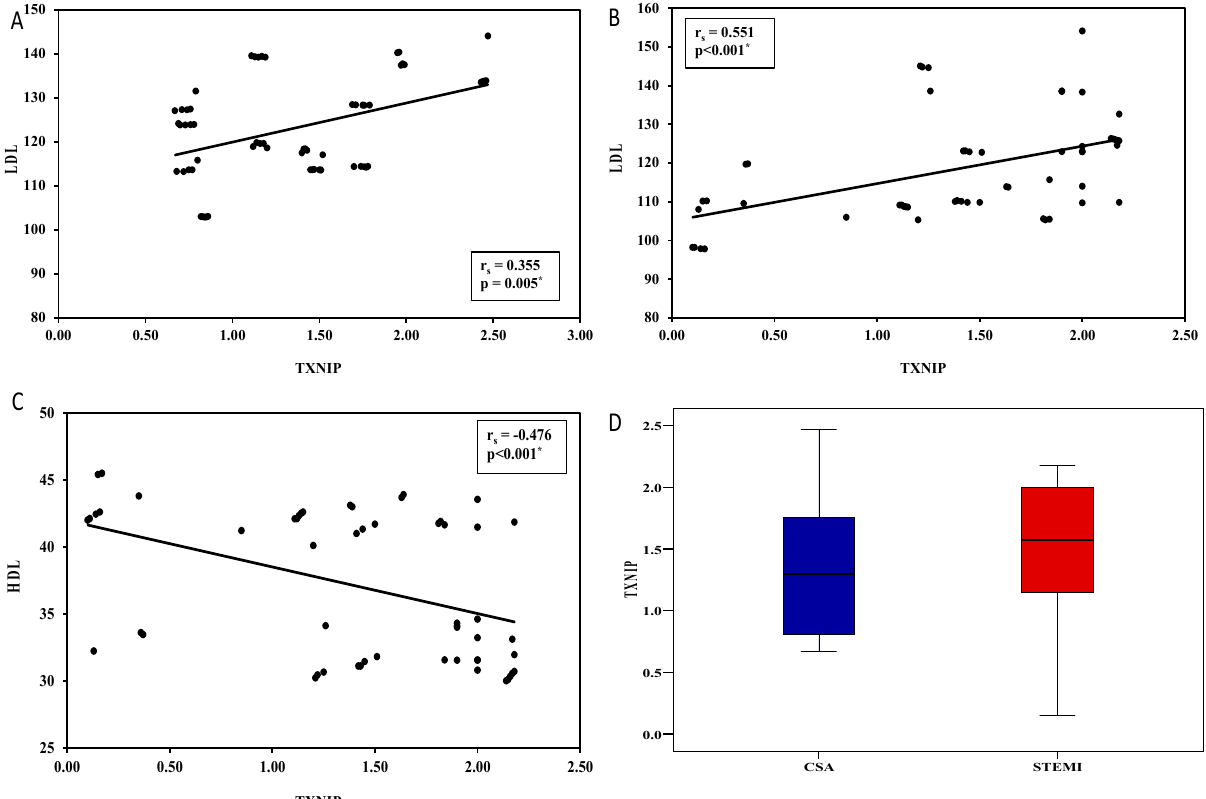
Figure 2. ( A ) Correlation between TXNIP and LDL in group II ( B ) Correlation between TXNIP and LDL in group III( C ) Correlation between TXNIP and HDL in group III ( D ) Relation between CSA and CS according to TXNIP expression. Table 4. Analytical performance of mRNAs PIK3C2A and TXNIP to distinguish different studied